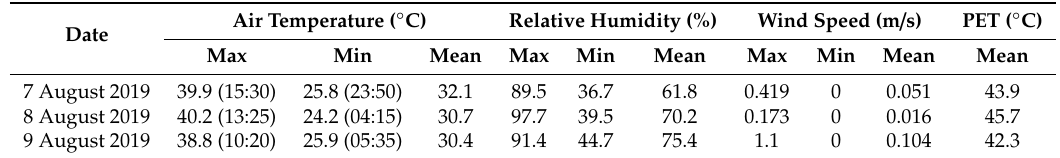
Table 2. The climatic data statistics from the study period.